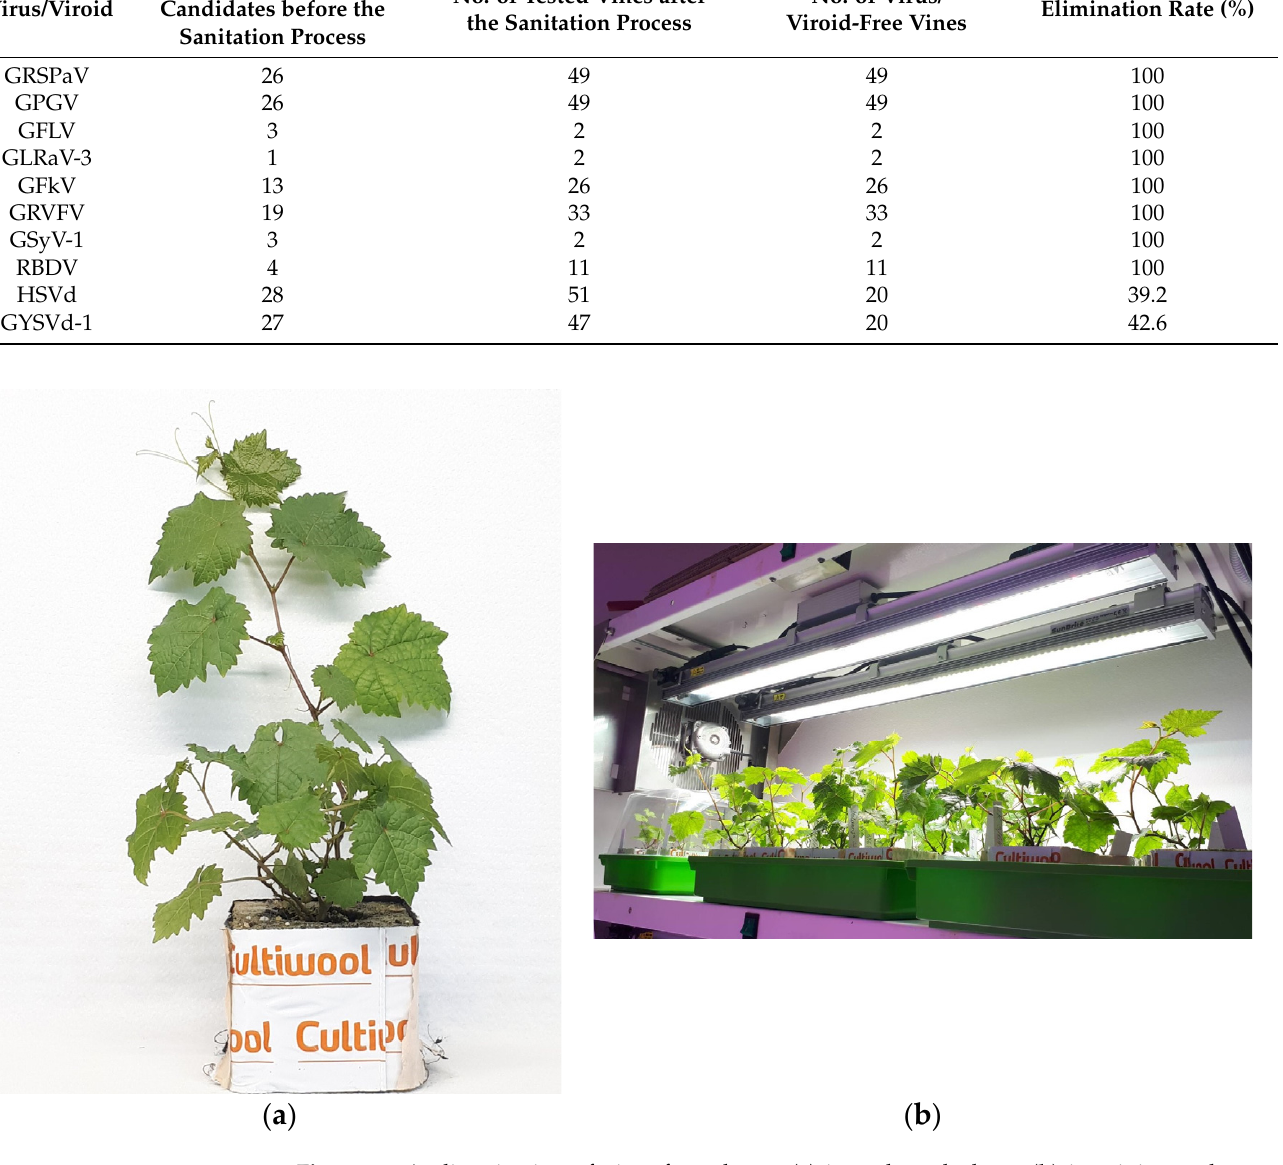
Figure 3. Acclimatization of virus-free plants: ( a ) in rockwool plugs; ( b ) in mini greenhouses maintained in a growth